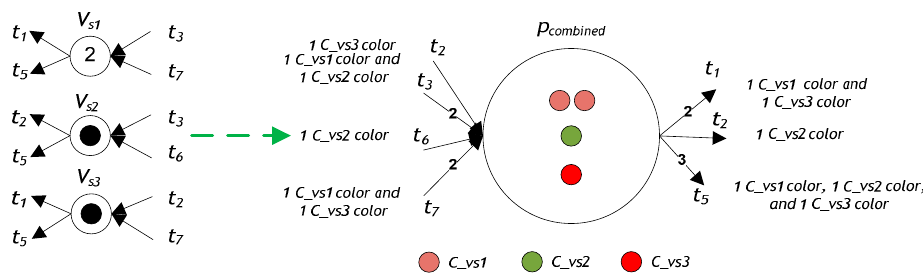
Figure 6. Merged controller for all monitors P V .